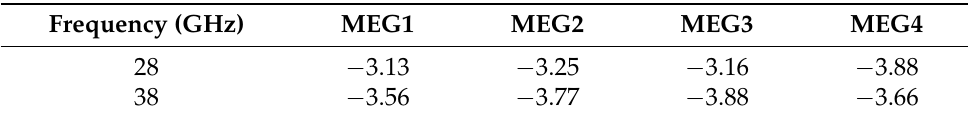
Table 1. MEG of the proposed antenna system.